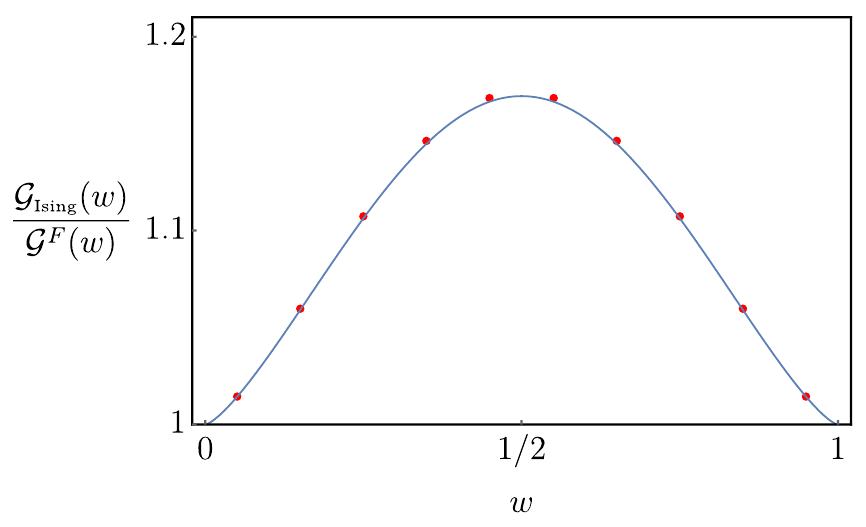
Figure 3 . Comparison between the 3d Ising spin field correlator and its approximation as a sum of two Polyakov blocks. The results are normalized relative to the generalized free fermion correlator G F ( w ) . The line is the correlator as computed from the conformal block expansion up to dimension 10, plotted in the interval w ∈ (0 , 1 / 2) which is then mirrored to get a crossing symmetric shape. This is not necessary for the Polyakov block approximation which is automatically crossing symmetric and shown as the red